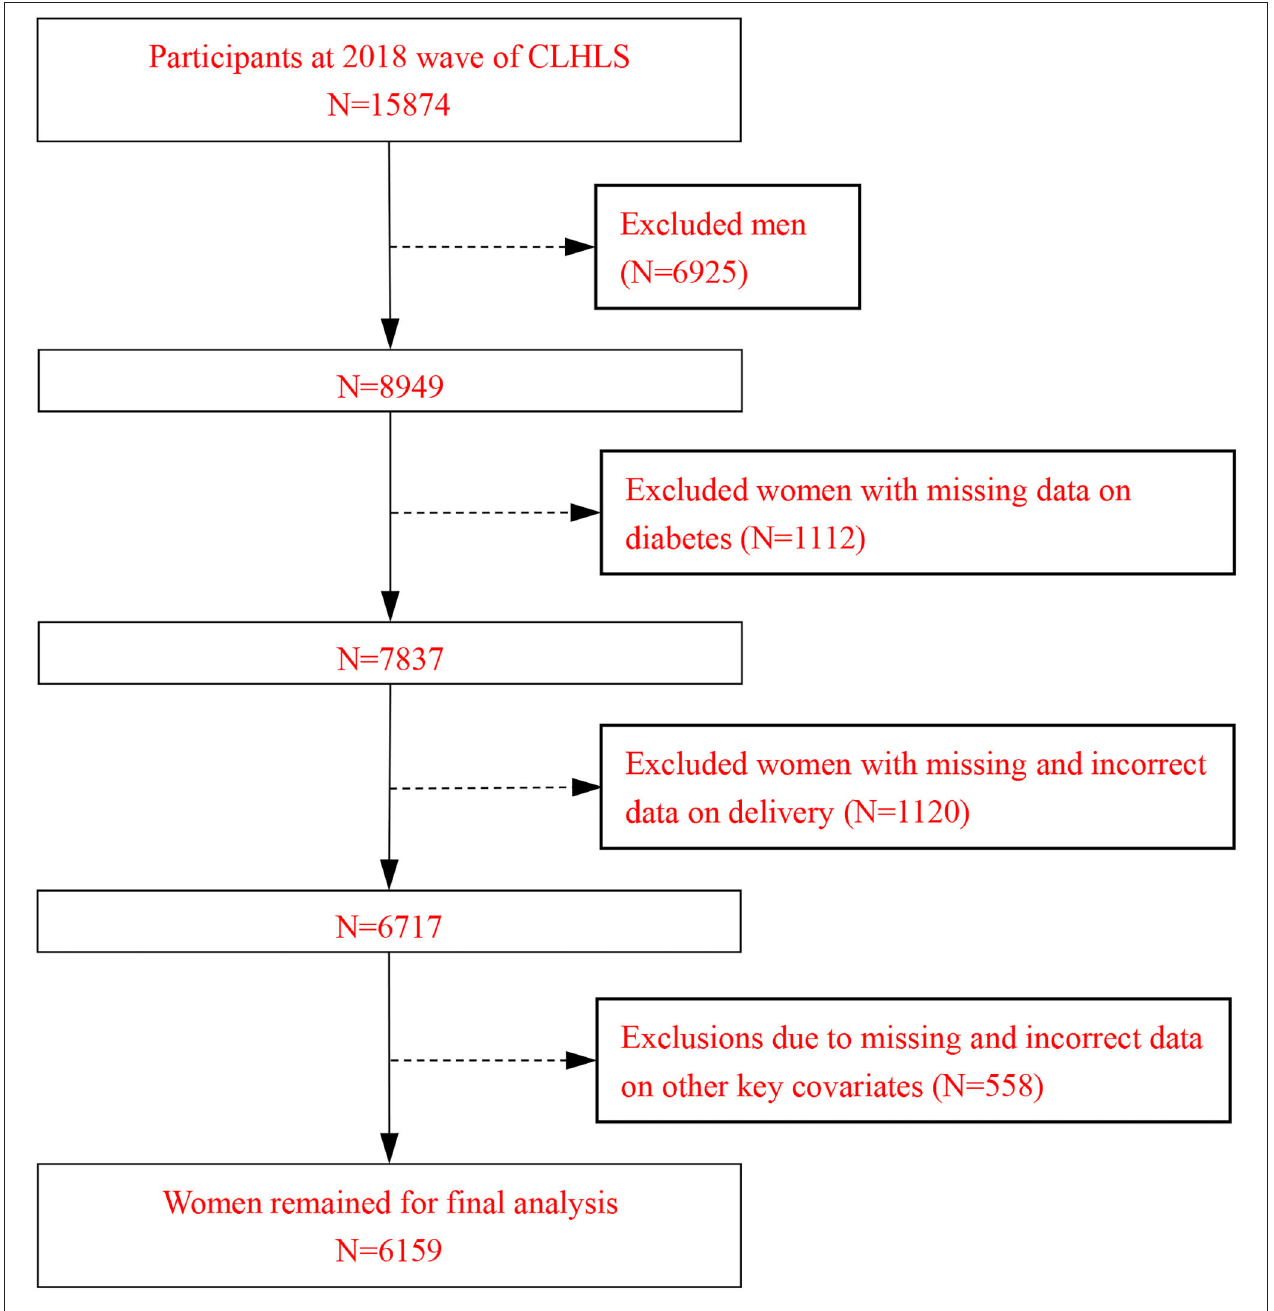
FIGURE 1 | Flow chart of the study population selection process.